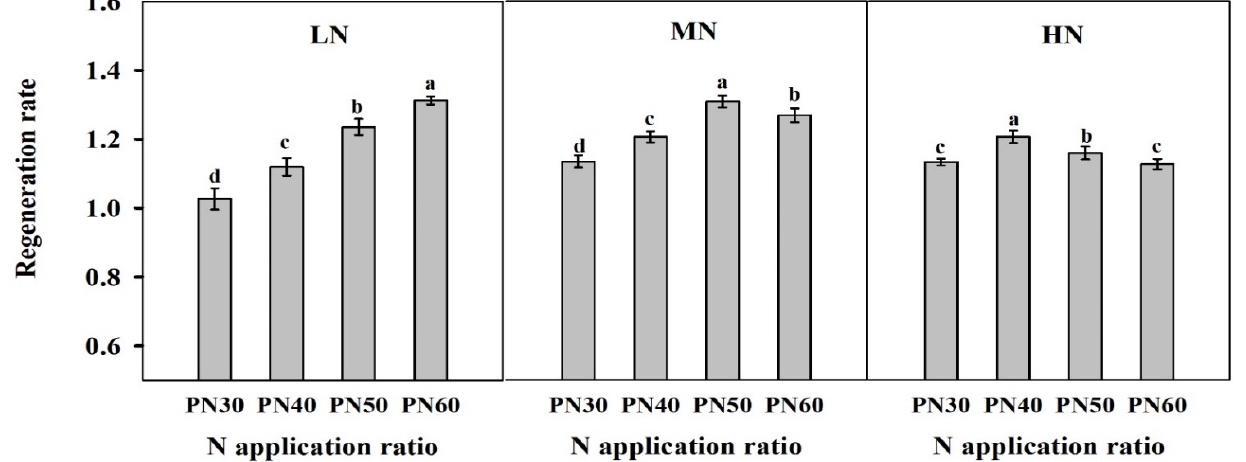
Figure 2. Effects of N rate and the ratio of the main crop on the regeneration rate. Error bars are ± SE. Note: LN, low N rate (the total amount of N applied was 100 kg ha − 1 ); MN, medium N rate (the total amount of N applied was 250 kg ha − 1 ); HN, high N rate (the total amount of N applied was 400 kg ha − 1 ). PN30, PN40, PN50, and PN60 correspond to N application ratios of basal tillering fertilizer to panicle fertilizer of 7:3, 6:4, 5:5, and 4:6, respectively. The different lowercase letters at the same growth stage indicate significant differences at the 5% probability level according to the LSD test.